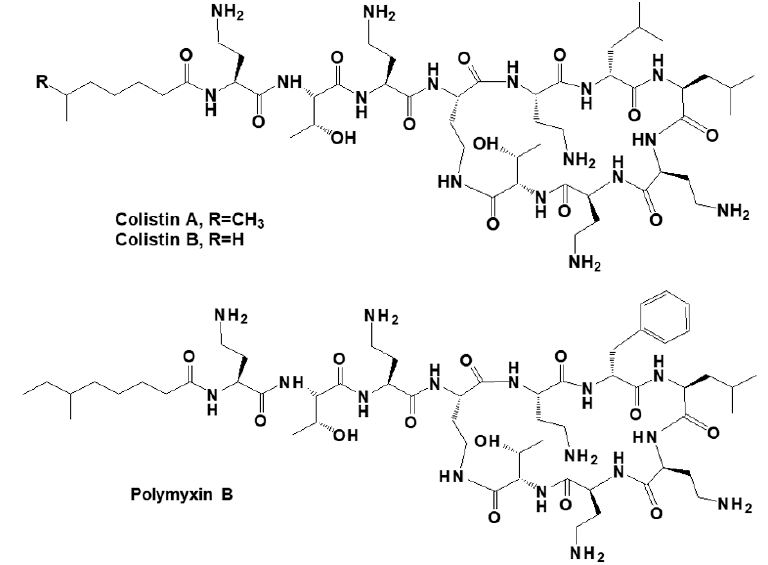
Figure 1. Chemical structures of colistin and polymyxin B.